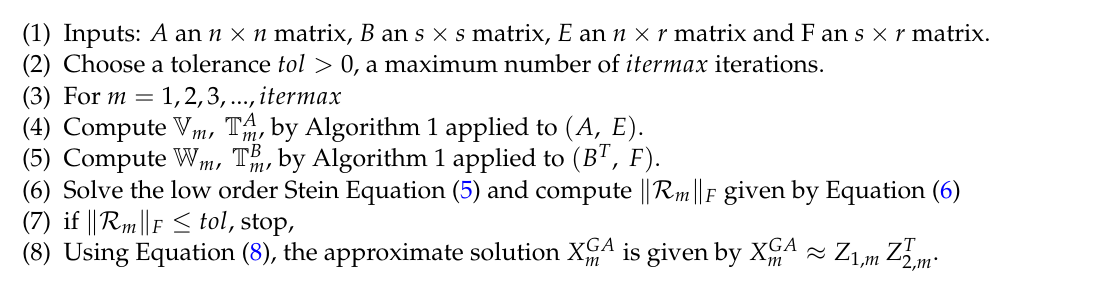
Algorithm 2. Galerkin Approach (GA) for the Stein Matrix